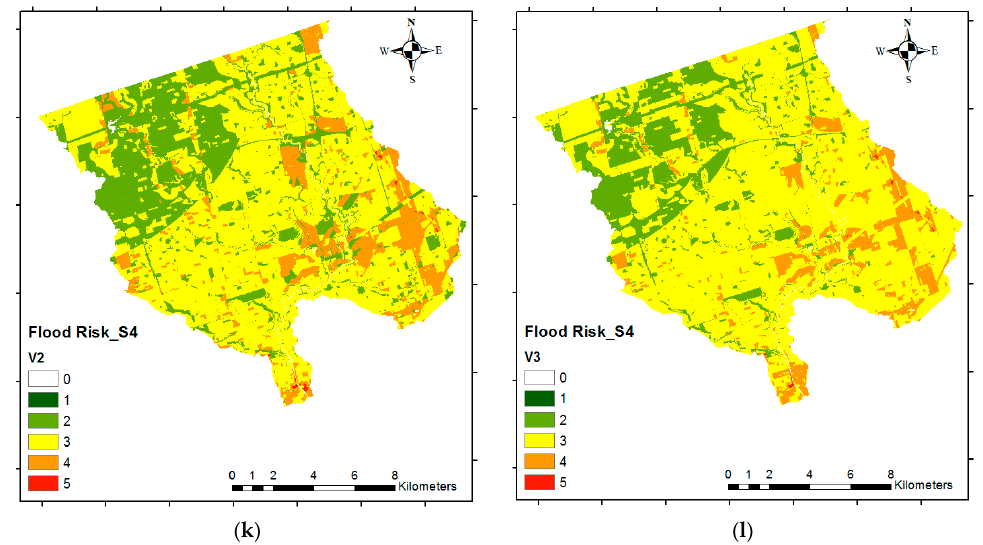
Figure 9. Flood risk maps for total vulnerability scenario; ( a ) S1_V1; ( b ) S1_V2; ( c ) S1_V3; ( d ) S2_V1; ( e ) S2_V2; ( f ) S2_V3; ( g ) S3_V1; ( h ) S3_V2; ( i ) S3_V3; ( j ) S4_V1; ( k ) S4_V2; ( l )